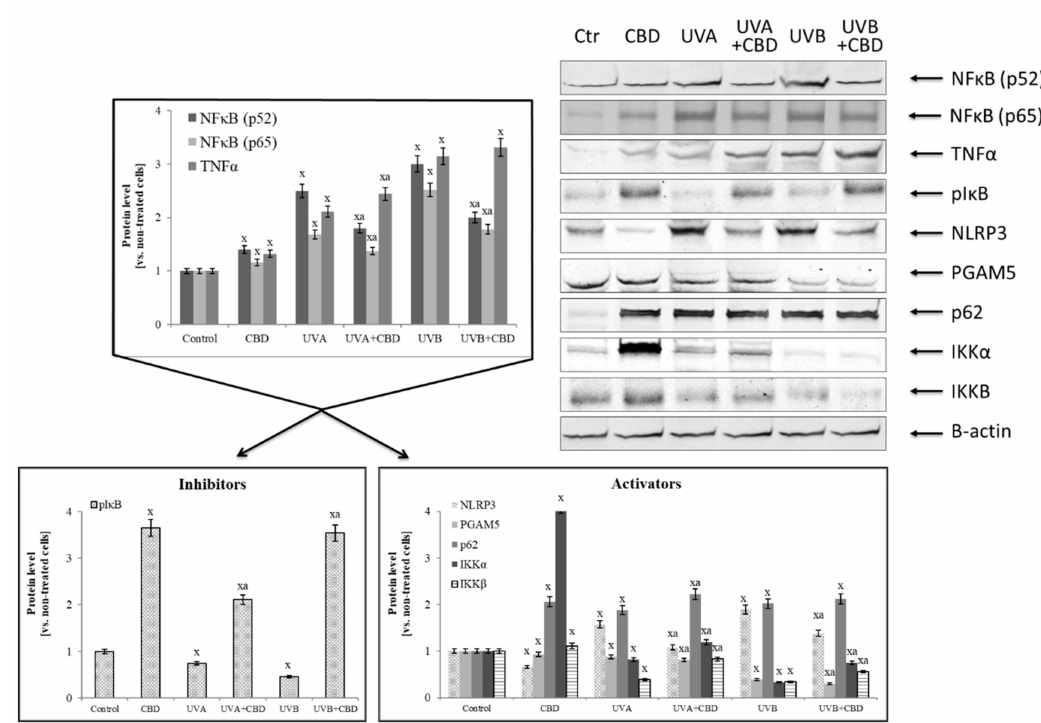
Figure 4. The influence of cannabidiol (CBD) on NF κ B [p52] and NF κ B [p65] transcriptional activity and its activators and inhibitors expression in keratinocytes exposed to UVA (30 J / cm 2 ) and UVB (60 mJ / cm 2 ) irradiation. Mean values ± SD of five independent experiments are presented. x statistically significant di ff erences vs. control group, p < 0.05; a statistically significant di ff erences vs. group without cannabidiol, p <